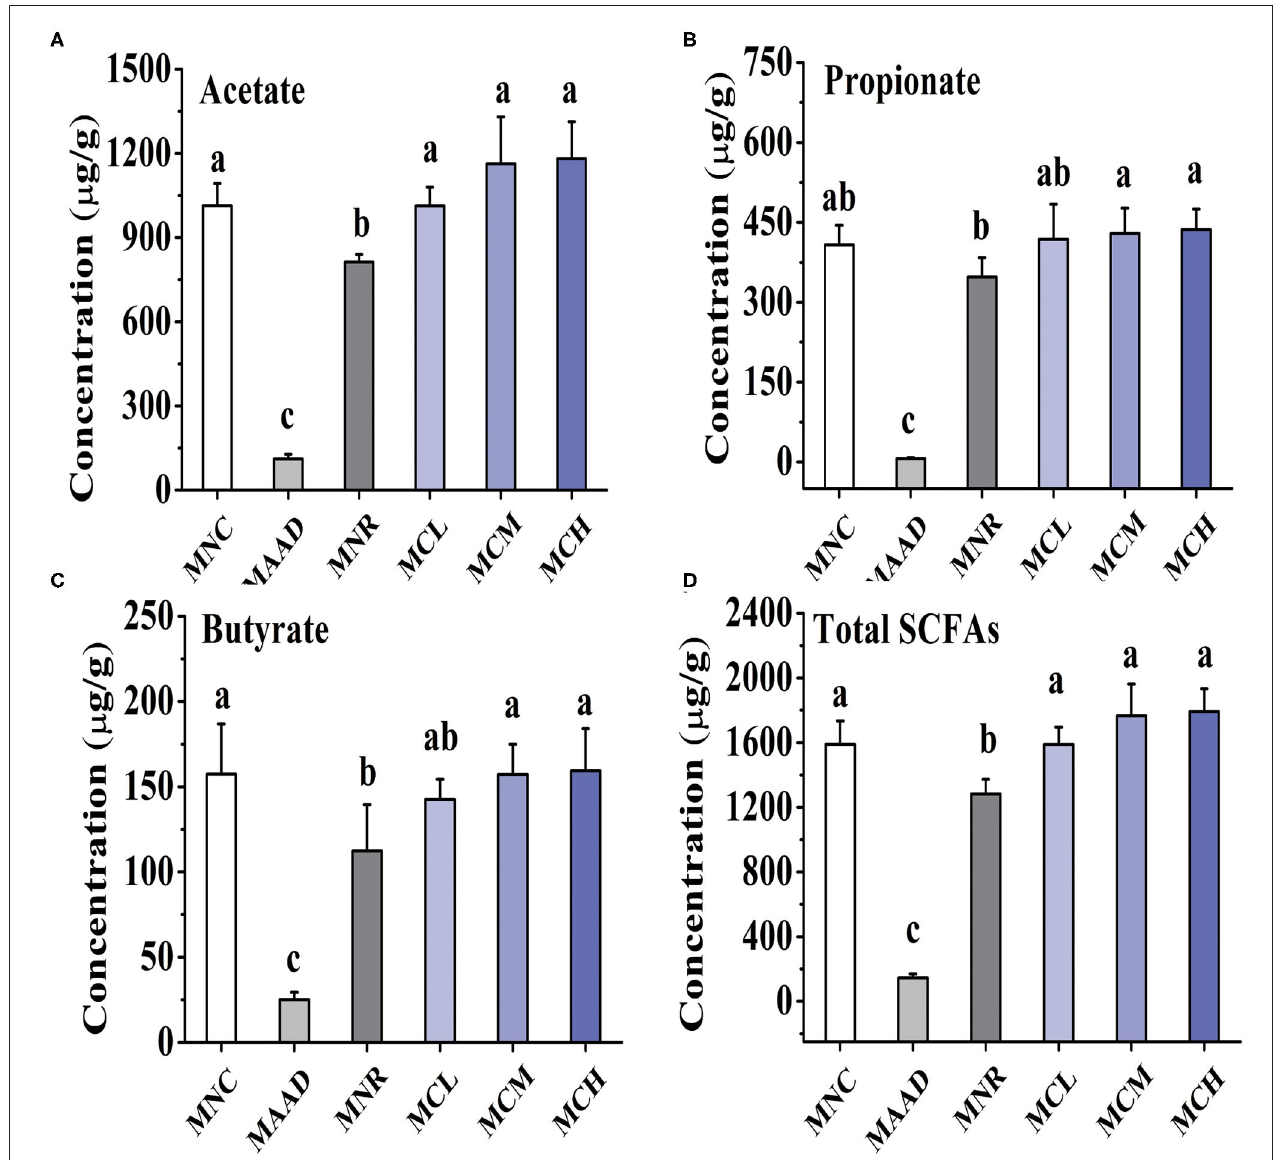
FIGURE 4 | Changes in concentrations of acetate (A) , propionate (B) , butyrate (C) and total SCFAs (D) . Values are shown as means ± SD. Different letters are significant differences ( p <